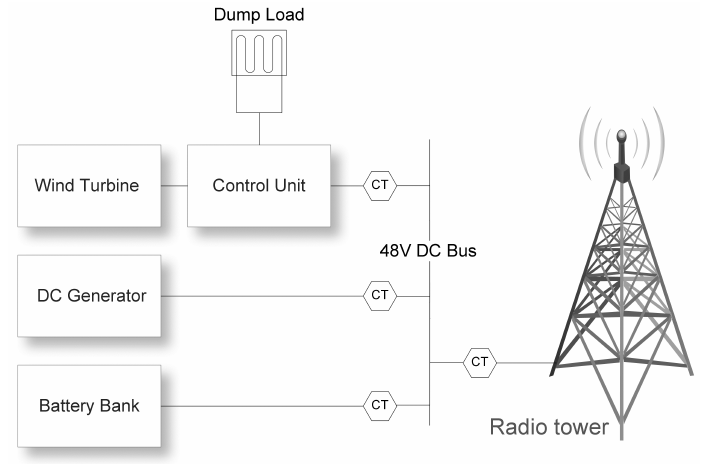
Off-grid hybrid energy system (HES) with current transducer (CT) measurement